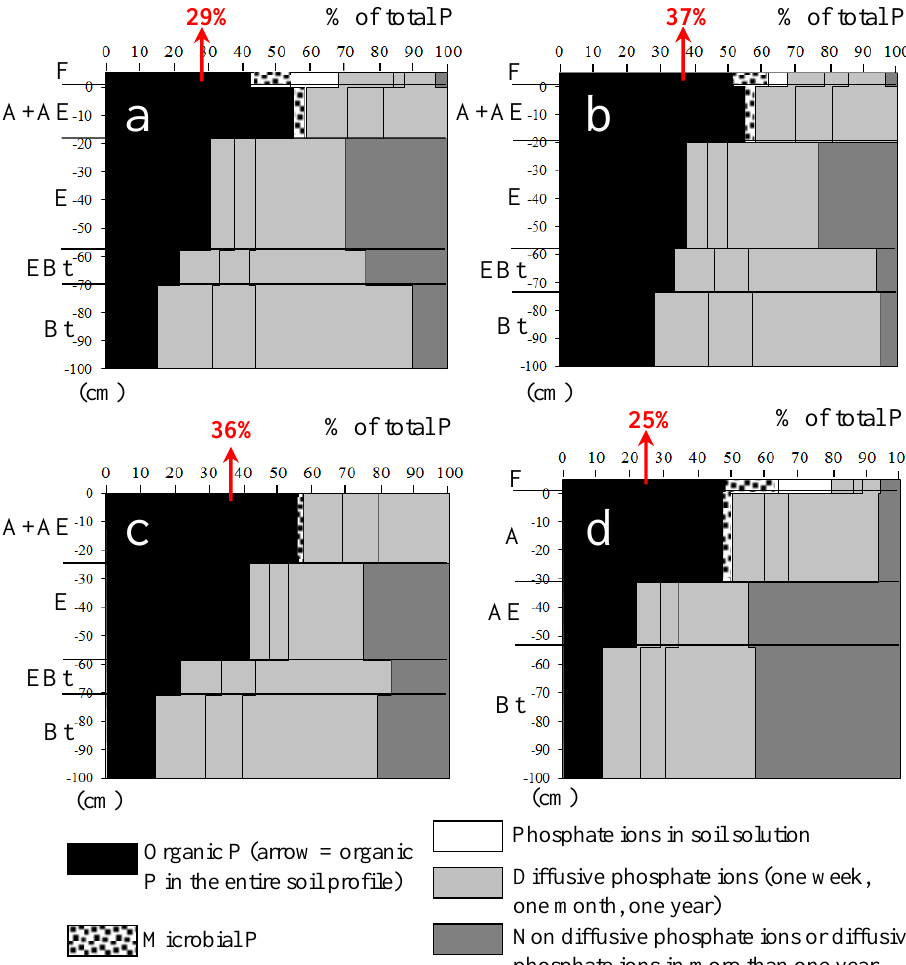
Fig. 3. Conceptual diagram of the different P fractions as a percentage of total phosphorus and as a function of soil depth in the four study plots. Plot 1 in ( a) , plot 2 in ( b) , plot 3 in ( c) , plot 4 in ( d)